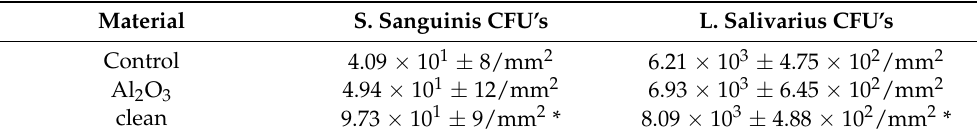
Table 4. CFU’s quantification for different titanium surfaces. Statistical differences are expressed by a single asterisk for each column ( p < 0.05).